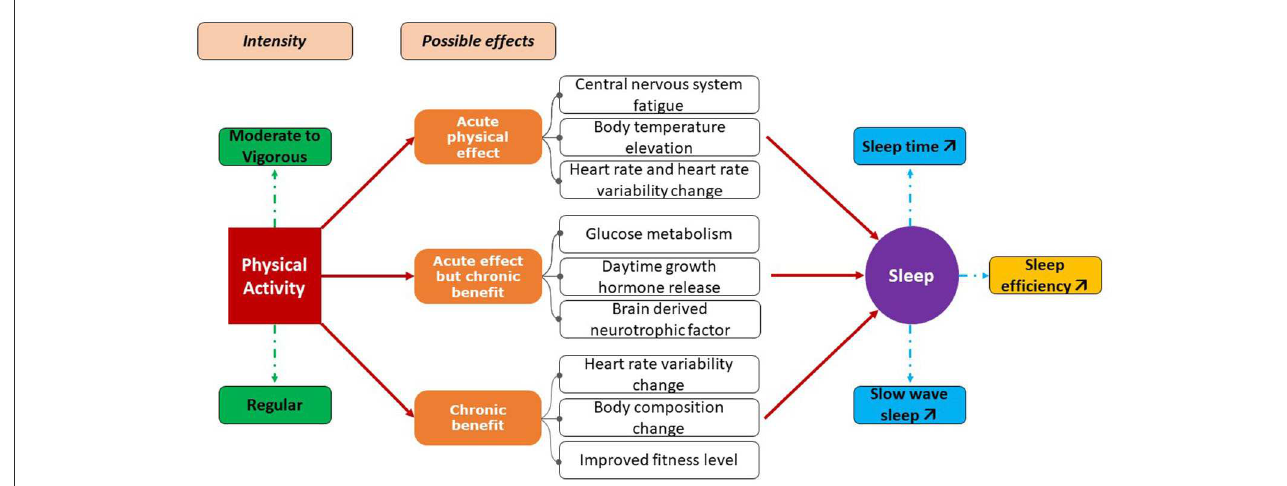
FIGURE2 Positive effects of physical activity on